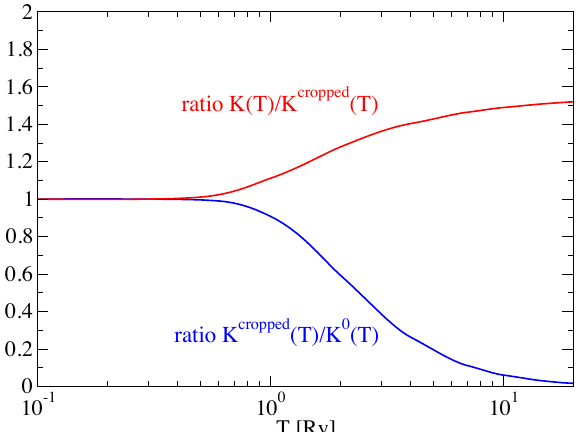
Figure 5. Mass action constants for the He + ion. The ratio K cropped ( T ) / K 0 ( T ) shows the effect of subtracting the low-order terms with respect to the interaction, − 1 + E 0 / k B T , for the reduced intrinsic partition function where only the ground state is considered. The ratio K ( T ) / K cropped ( T ) compares the fully cropped intrinsic partition function with the reduced cropped partition function to show the effect of including excited